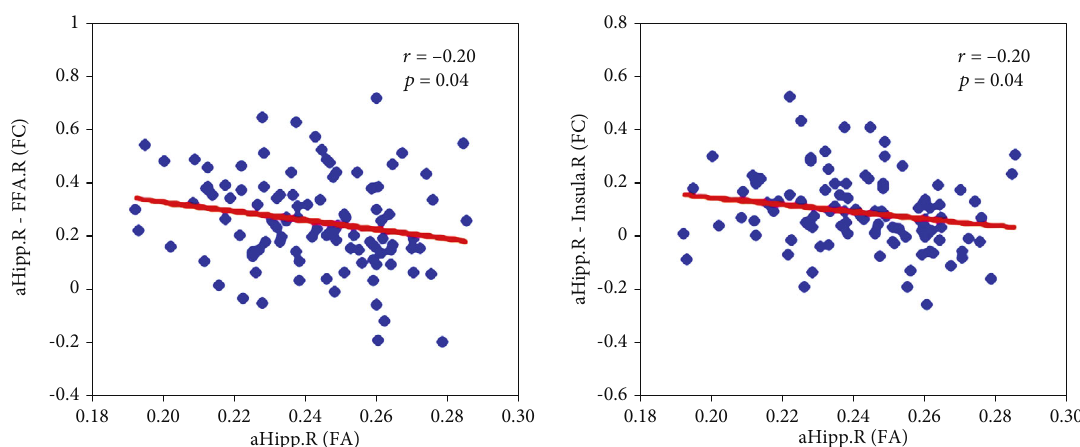
Figure 4: Correlation between FC values and white matter structural FA values in hippocampus subregions.